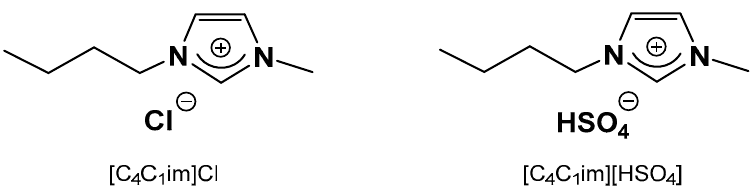
Figure 4. Ionic liquids used for the dissolution and breakdown of biomass in this work.